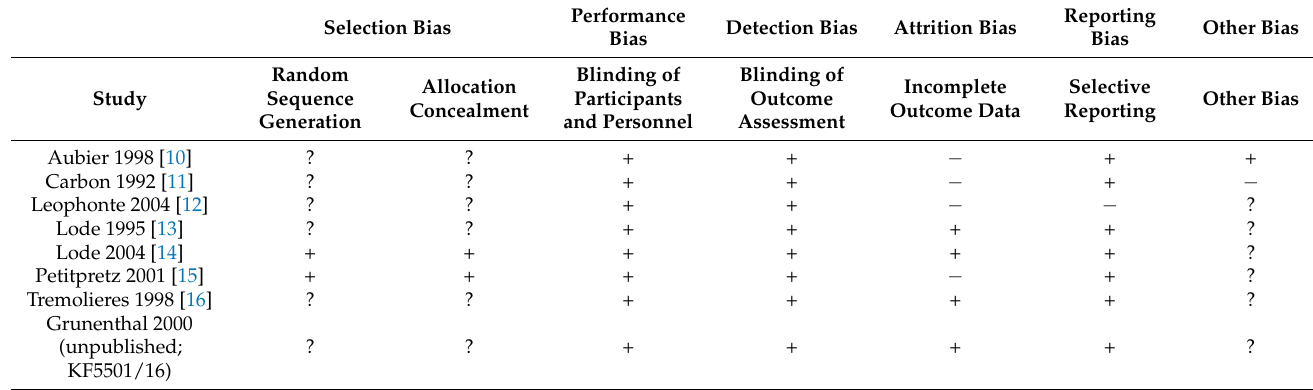
Table 2. Quality assessment of the included studies.